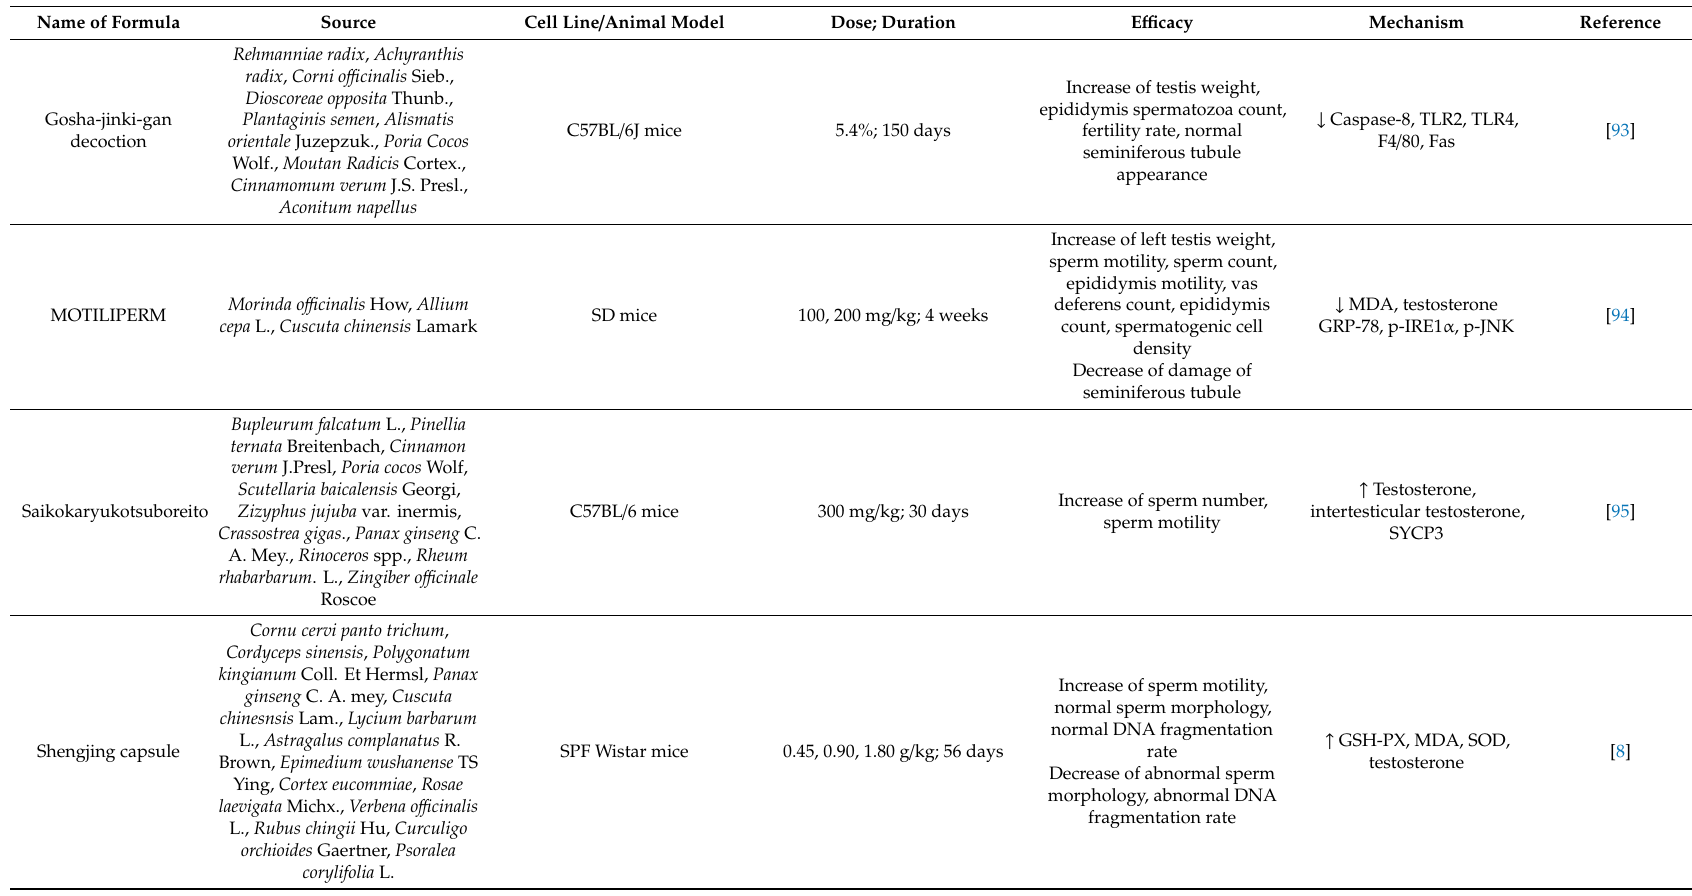
Table 6. Formula and male